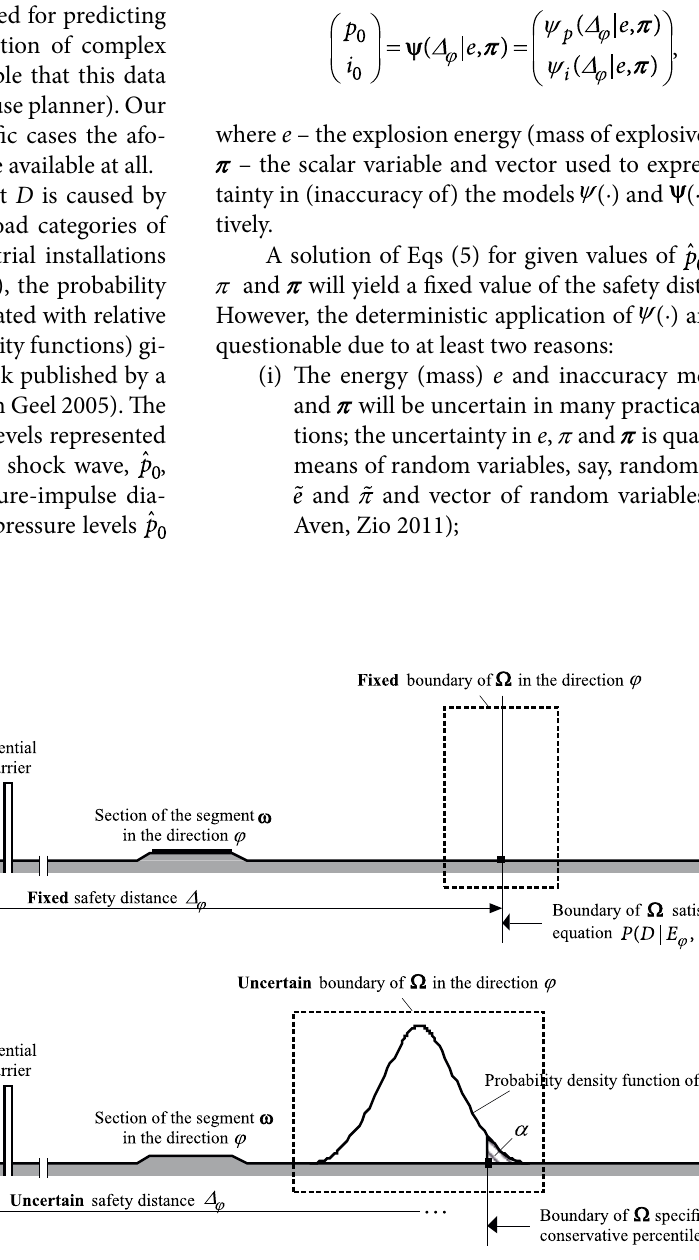
Fig. 3. Two approaches to a specification of the safety distance : a – specification of a fixed value of based on a tolerable value P tol of the damage probability ; b – specification of based on a fixed tolerable value of explosion effect and yielding a boundary of the unsafe zone defined by a percentile of